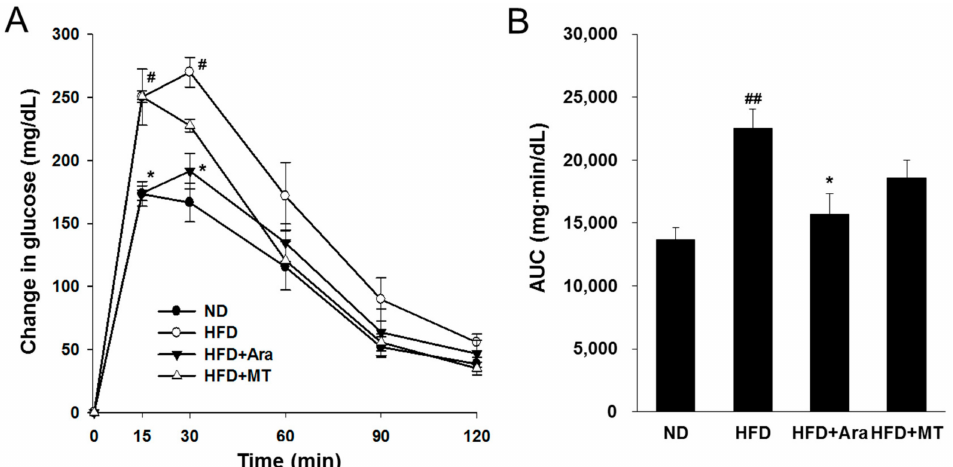
Figure 1. Arazyme improved oral glucose tolerance test (OGTT) in HFD-fed NAFLD-like mice. ( A ) Blood glucose levels were measured at 0, 15, 30, 60, 90, and 120 min after glucose (2 g · kg − 1 body weight) administration. # p < 0.05 vs. ND; * p < 0.05 vs. HFD by two-way ANOVA. ( B ) The area under the curve (AUC) of plasma glucose during OGTT. Data are presented as means ± SE ( n = 4). ## p < 0.01 vs. ND; * p < 0.05 vs. HFD by one-way ANOVA.